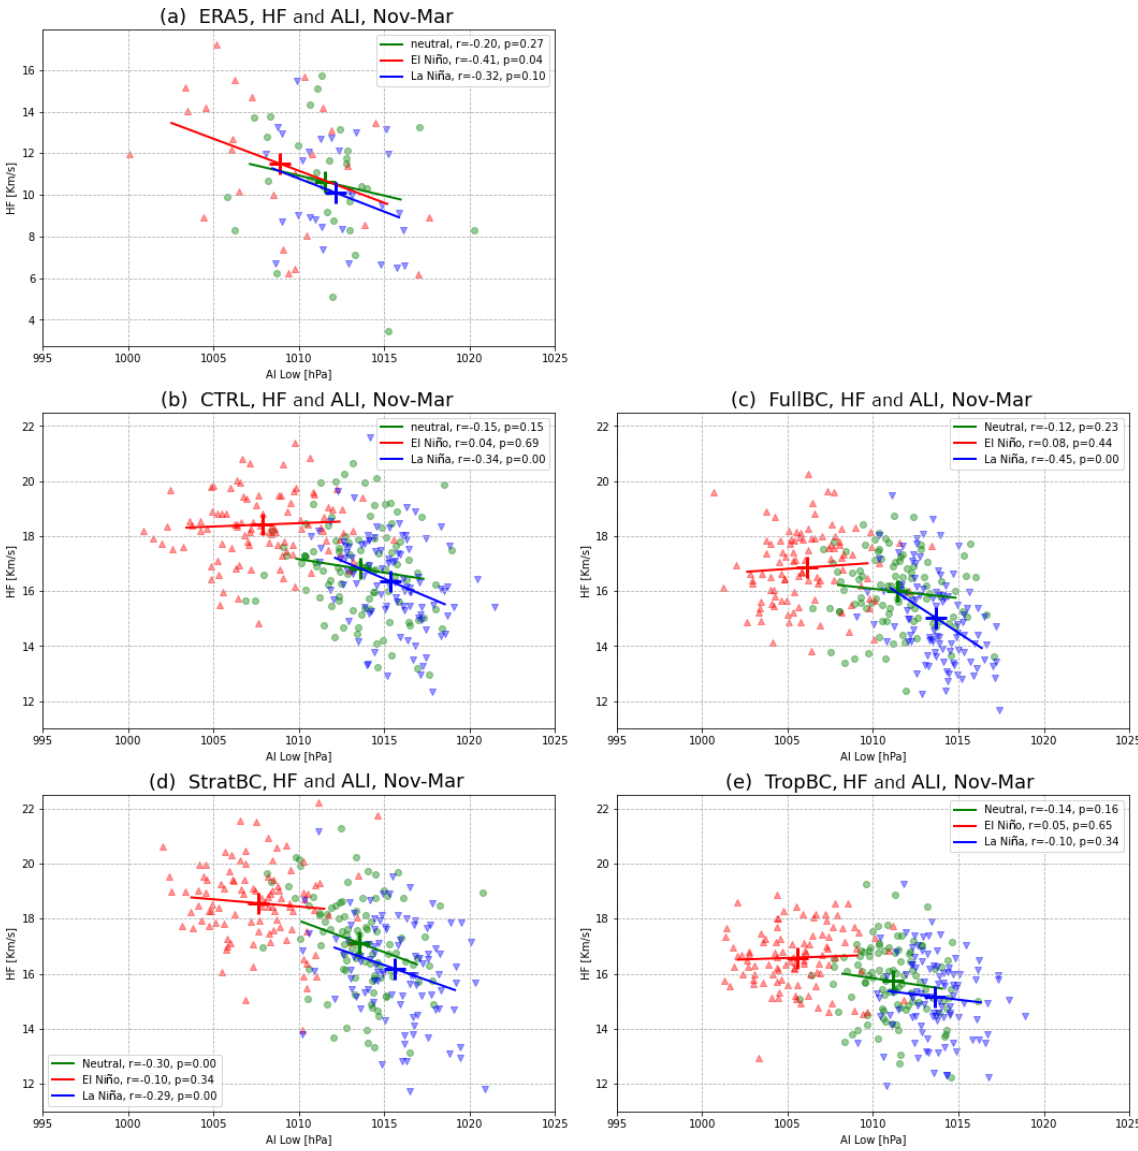
Figure 6. Scatterplot with regression line of mean NDJFM values of the Aleutian low index and the heat flux between 45–75 ◦ N at 100hPa, for (a) ERA5 (1950–2020), (b) CTRL, (c) FullBC, (d) StratBC, and (e) TropBC. Neutral years are green, El Niño years are red, and La Niña years are blue. Correlation and p values are shown in the